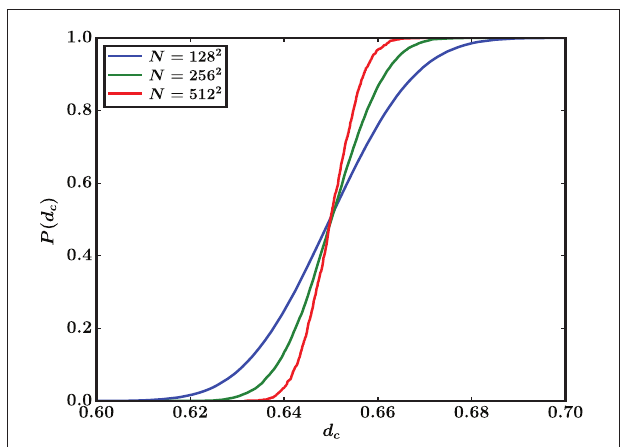
FIGURE 11 | Cumulative distribution of critical damage P ( d c ) for LLS on a square lattice. The number of samples is 1.5 × 10 5 , 1.5 × 10 4 , and 1.5 × 10 3 for system sizes N = 128 2 , 256 2 , and 512 2 , respectively. The threshold distribution is P ( t ) = 1 − e − t